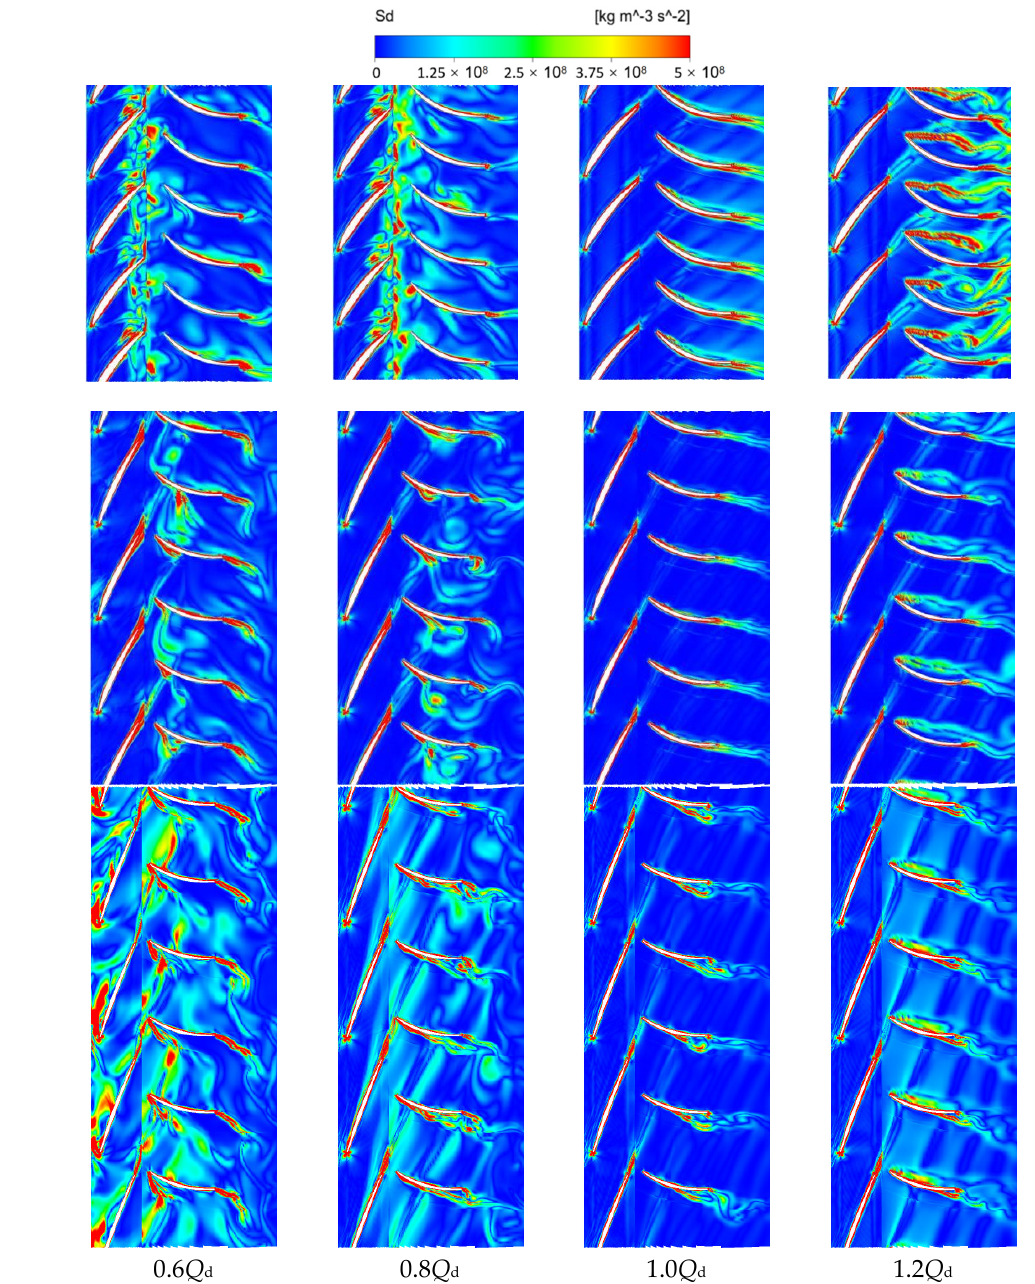
Figure 12. Dipole source distribution in the impeller and guide vane.